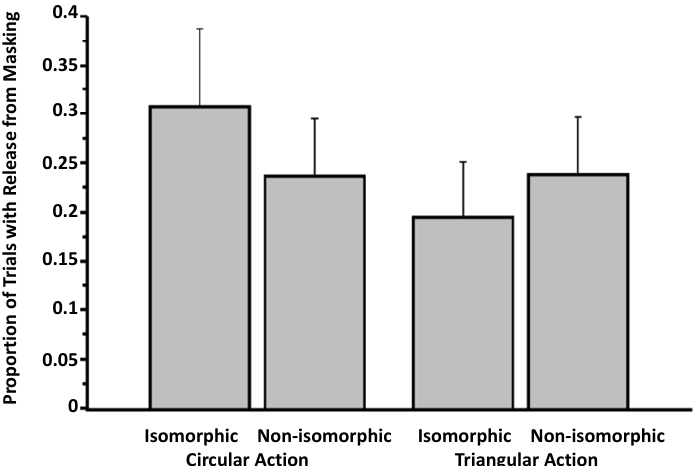
Figure 3. Proportion of trials involving release from masking as a function of action and isomorphism (Experiment 2). The data are culled from the question, “Did you see anything on the screen other than the pattern mask?” Error bars signify